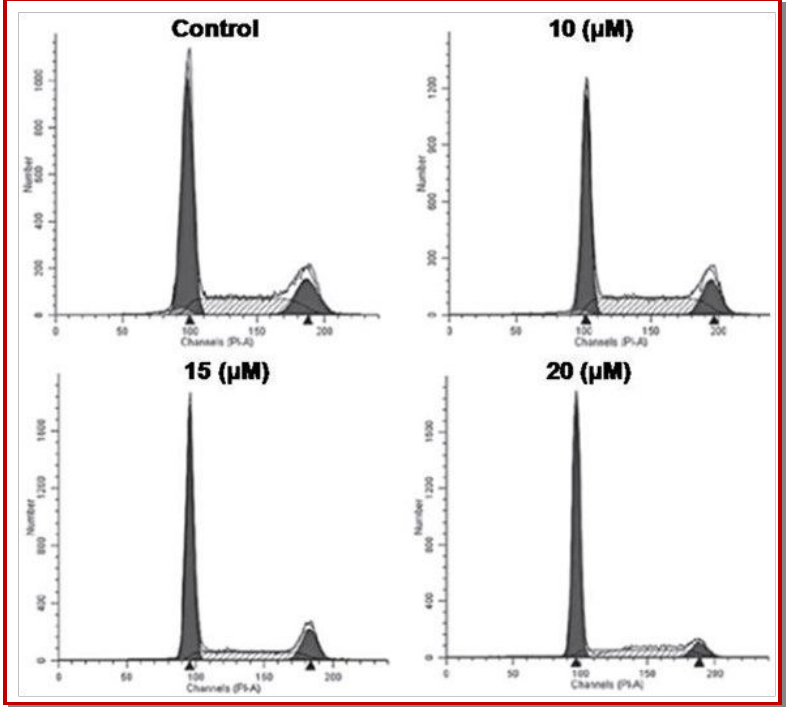
Figure 4: Zerumbone treatment caused arrest of cell cycle in DU-145 carcinoma cells. The cells were incubated with zerumbone, stained with PI and then examined by flow cytometry